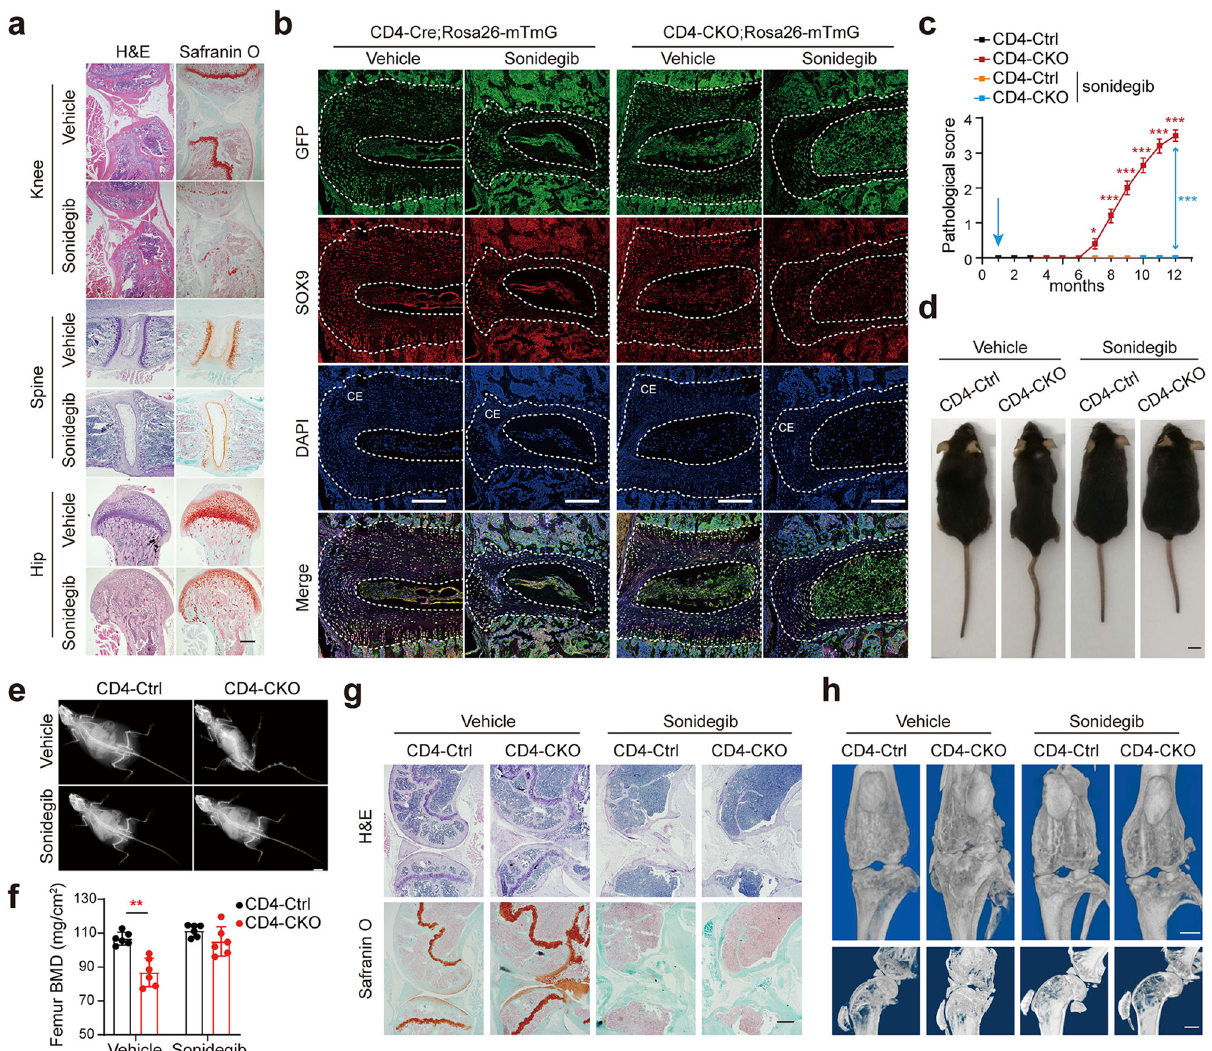
Fig. 5 Premature fusion of the growth plate prevents AS-like bone disease in CD4-CKO mice. Three-week-old CD4-CKO;Rosa26-mTmG mice and CD4- Cre;Rosa26-mTmG littermates were orally gavaged every other day with Smo inhibitor, sonidegib (50 mg/kg) for three times. a Sagittal joint sections of 2-month-old mice treated with sonidegib or not were stained with H&E and SOFG. Scale bars: 400 μ m. b Spinal sections of 2-month-old mice were immunostained with marker protein GFP, transcriptional regulator SOX9 and nuclear counterstain DAPI. CE represents cartilaginous endplate between white dotted line. Scale bars: 200 μ m. c Pathological scores of CD4-CKO mice treated with sonidegib or not ( n = 10). d – f Gross images ( d ), X-ray radiographs ( e ), and femoral BMD ( n = 6) ( f ) show bone lesions and decreased femoral BMD were merely occurred in CD4-CKO mice. Scale bars: 1 cm. g H&E and SOFG staining images. Scale bars: 400 μ m. h μ -CT radiographs of 12-month-old mice show bone deformation and cartilage abnormalities in CD4-CKO mice without sonidegib treatment and merely smaller skeleton in sonidegib-treated CD4-CKO mice and CD4-Ctrl mice. Scale bars: 1 mm. c and f Data are presented as mean ± SEM. c ** p < 0.01, *** p < 0.001, f ** p -value = 0.0004, determined by two-tailed Student ’ s t -test. a , b , d , e , g , h Data are representative of three independent biological